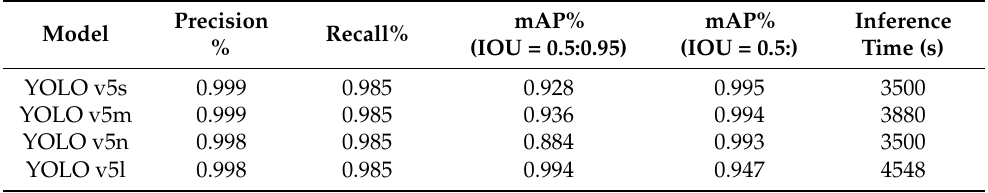
Table 4. The detection results of the different YOLO v5 models.